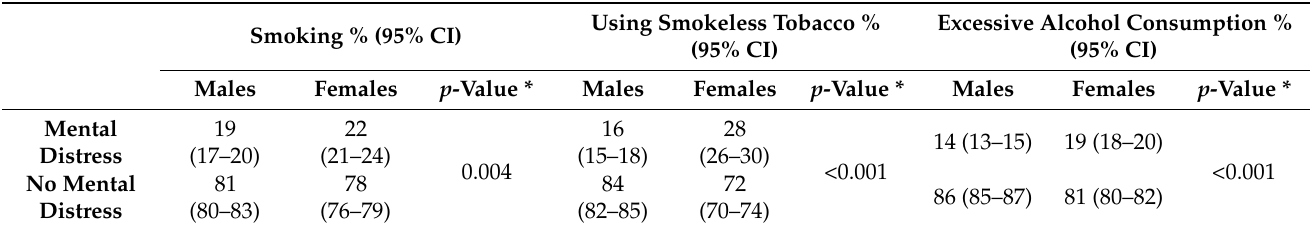
Table 3. Differences in mental distress between male and female substance